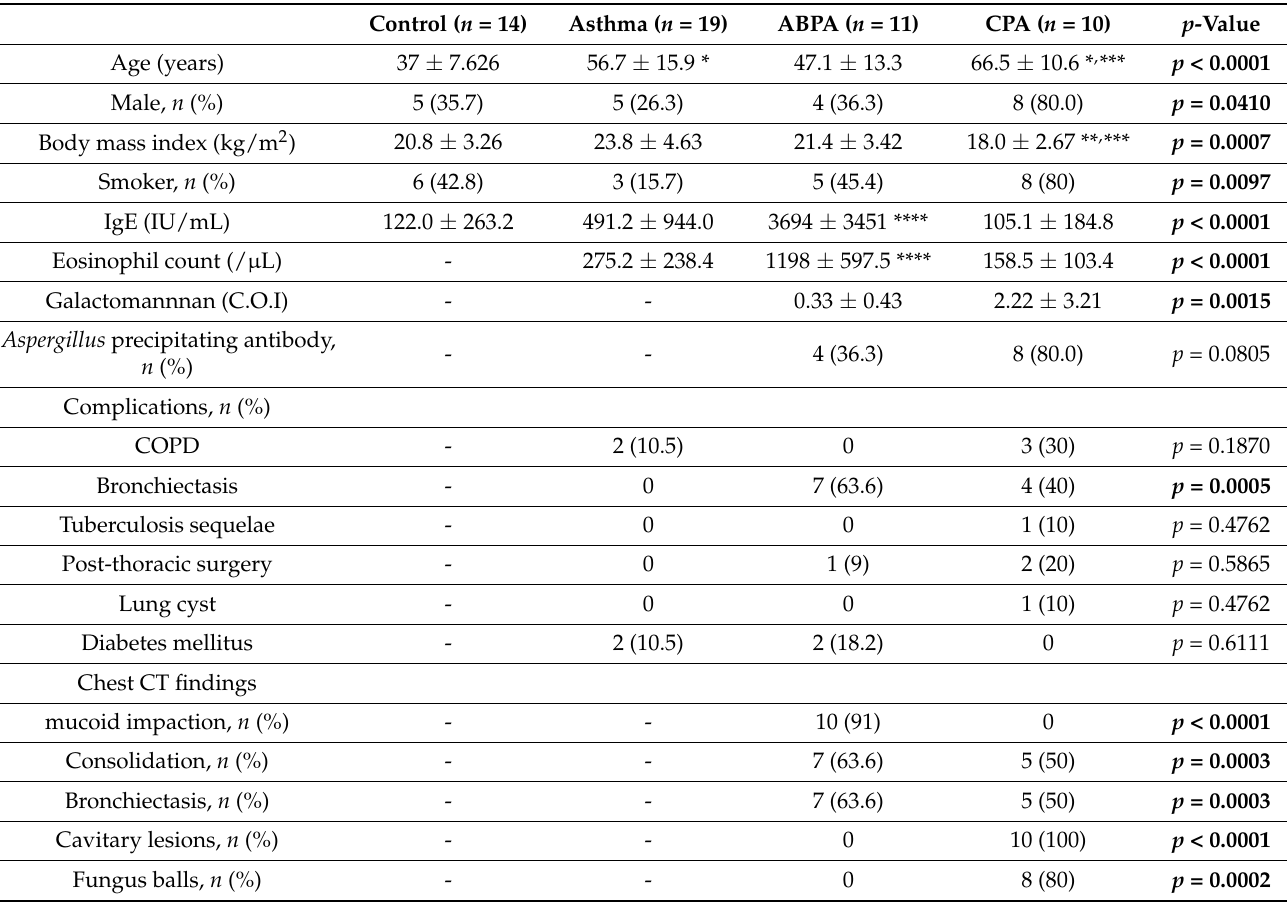
Table 1. Characteristics of Study Participants.